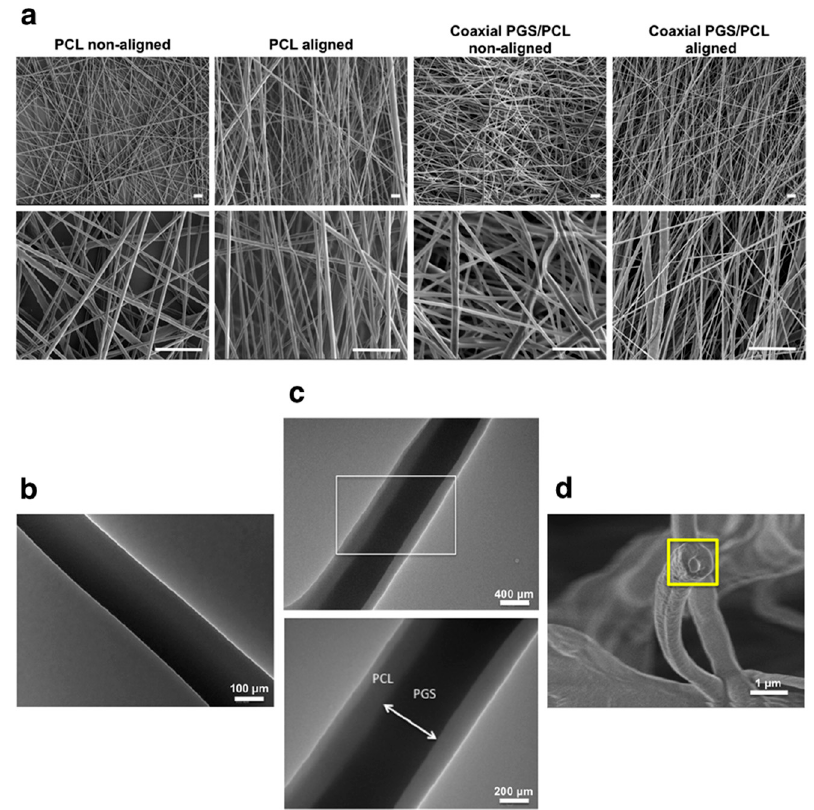
Figure 9. Monolithic and core-shell electrospun fibres. Scanning electron microscopy (SEM) images ( a ) of aligned and non-aligned monolithic PCL and core-shell PGS-PCL fibres at two different magnifications. Scale bars: 5 μ m. Transmission electron microscopy (TEM) images of ( b ) PCL monolithic fibres and ( c ) PGS-PCL core-shell fibres. The bottom panel in c is a magnification of the area within the white box in the top panel. The core-shell structure of PGS-PCL fibres was also confirmed by SEM imaging of the fibre cross-section ( d , yellow box). Abbreviations: PCL—poly( ε - caprolactone); PGS—poly(glycerol sebacate). Adapted from [289] with permission from Elsevier. Copyright © 2019, Elsevier